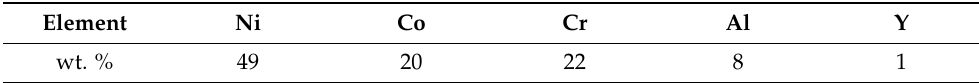
Table 2. The composition of NiCoCrAlY.